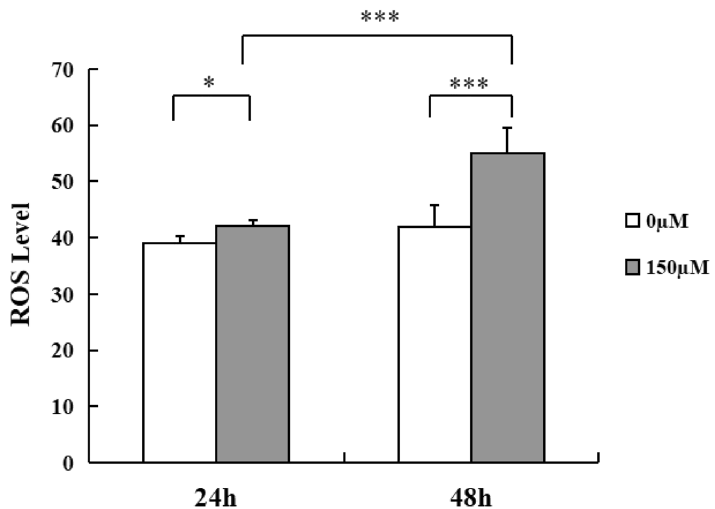
Figure 4. H 2 O 2 exposure activates intracellular ROS activity of MECs. Quantitative analysis of intracellular ROS in MECs exposure to H 2 O 2 (150 µM) for 24 h and 48 h respectively. Values are shown as mean ± SD (n = 6). * p < 0.05, *** p < 0.001. MECs, meningothelial cells; ROS, reactive oxygen